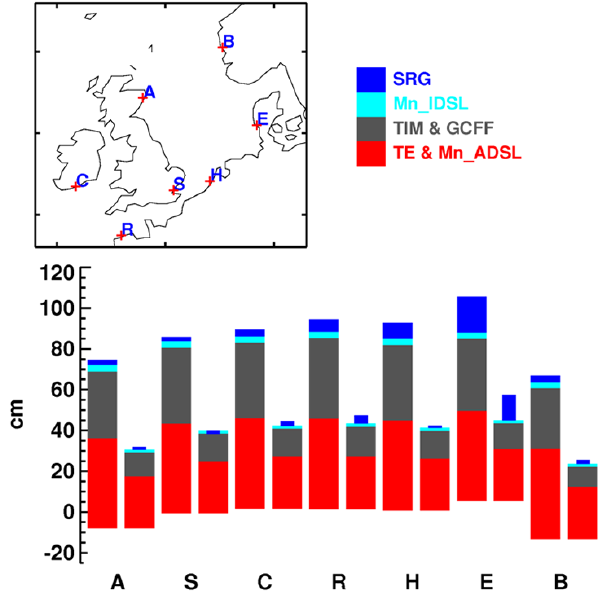
Figure 5. Addition of illustrative high-end (and representative mid- range) projections of contributions to 21st century change in the height of the 50-year storm surge for seven locations around NW Europe. The locations are Aberdeen, (A); Sheerness, (S); Cork Har- bour (C); Roscoff, (R); The Hague, (H); Esbjerg (E) and Bergen (B). For each location, the larger (left-hand) bar shows the high-end estimate, and the smaller (right-hand) bar shows the mid-range es- timate. The projected contribution from GIA is shown as an offset to the zero of each bar. The mid-range SRG projection at Sheerness is negative, and so that this can be seen, the mid-range SRG projec- tions are shown as half-width bars. Further details are given in the main